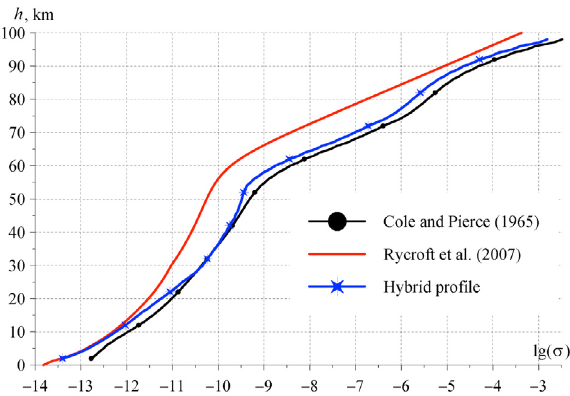
Figure 1. Comparison of height profiles of air conductivity v , given in units of